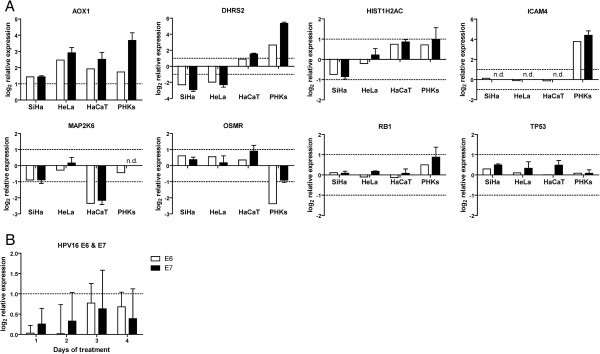
Gene expression evaluated by real-time RT-PCR. (A) The TaqMan® Fast Universal PCR Master Mix and TaqMan® Gene Expression Assays from Applied Biosystems were employed to determine expression of the following genes (with assay ID’s): AOX1 (Hs00154079_m1), DHRS2 (Hs01061576_m1), HIST1H2AC (Hs00374312_s1), ICAM4 (Hs00169941_m1), MAP2K6 (Hs00992389_m1), OSMR (Hs00384276_m1), TP53 (Hs99999147_m1), and RB1 (Hs01078075_m1) in SiHa, HeLa, HaCaT, and PHKs following CDV treatment for 72 h. White bars represent the relative expression values of the microarray data. Black bars represent average RT-PCR values (±SD), relative to untreated cells and normalized against β–actin, from three independent samples. (B) Relative expression levels of HPV16 E6 and E7 in SiHa cells following treatment with CDV for different times, relative to untreated SiHa cells and normalized against β–actin. The bars show average values (±SD) of at least three independent experiments. An absolute 2-fold change difference was considered as biologically significant and is indicated by dashed lines in the figures.